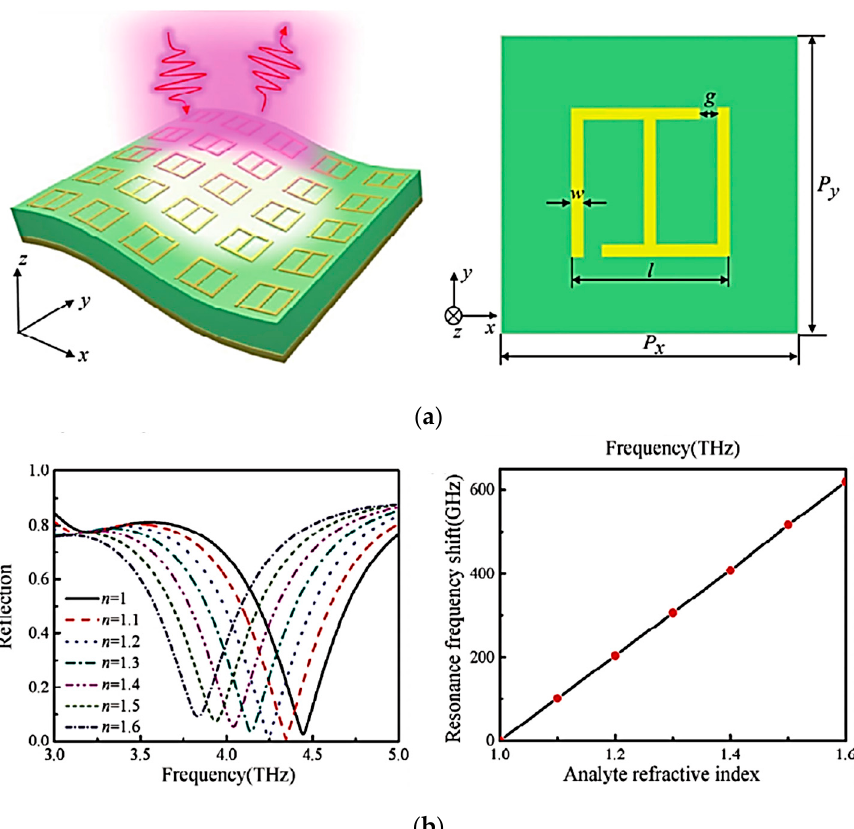
Figure 6. MPA biosensor. ( a ) Sensor structure; ( b ) reflection curve with the change of refractive index of the detected object [44].